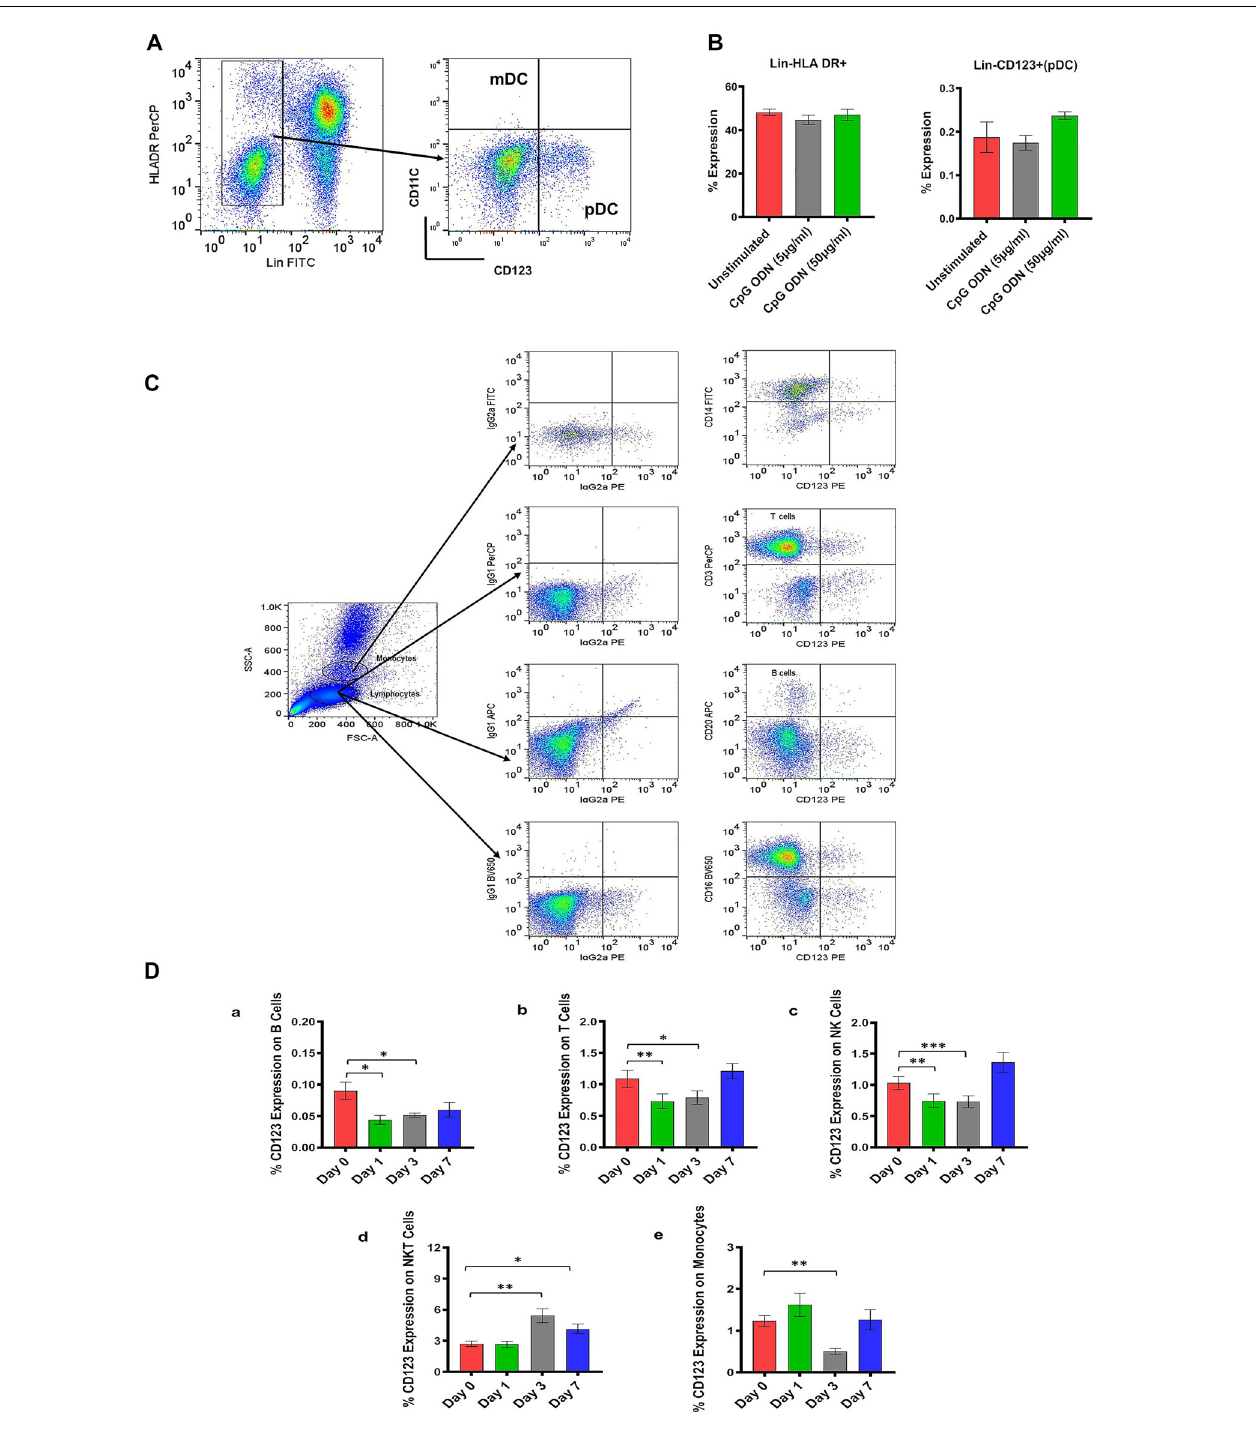
FIGURE 2 | (A) Gating scheme for identification of pDC (Lin-HLA DR+CD123+) in the peripheral blood. (B) Characterization of SQM plasmacytoid dendritic cells (pDCs) and analysis of CpG ODN effect on Lin-HLA DR+ and Lin-CD123+ expressing cells. Aliquots of the whole blood were stained with the Lin1-FITC antibody cocktail consisting of FITC-labeled antibodies to CD3, CD14, CD16, CD20, PE-labeled antibodies to CD123, and PerCP-labeled antibodies to HLA DR to identify pDCs. Values on the Y-axis represent % expression of Lin1-HLA DR+ and Lin-CD123+ cells evaluated in the presence (5 µ g/ml and 50 µ g/ml) or absence (unstimulated) of CpG ODN. P -values were considered statistically significant at p < 0.05. (C) Gating scheme for identification of CD123 expression on major